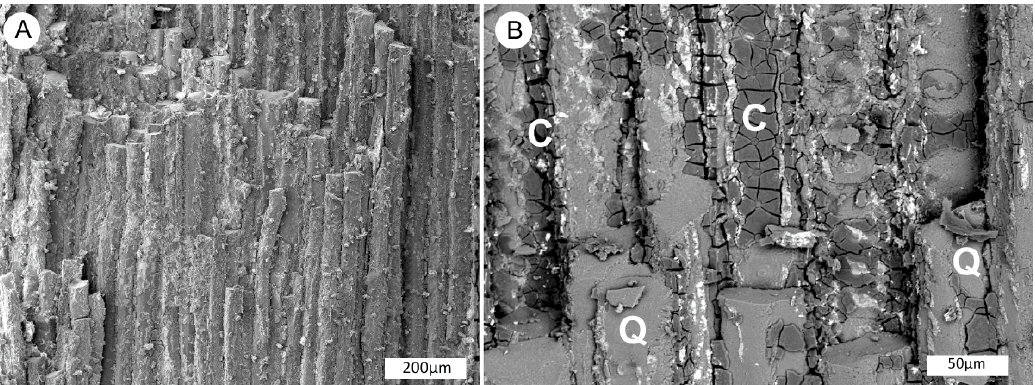
Figure 7. SEM views of silicified wood in light brown zone. ( A ) Longitudinal view shows tracheid cells that have been replaced by silica, secondary electron image. ( B ) Carbonaceous material (labeled C) is preserved as brittle material in areas of cell walls, quartz-mineralized wood is marked with Q. Thin stringers of coffinite (unlabelled) appear as white zones in this backscatter electron image.